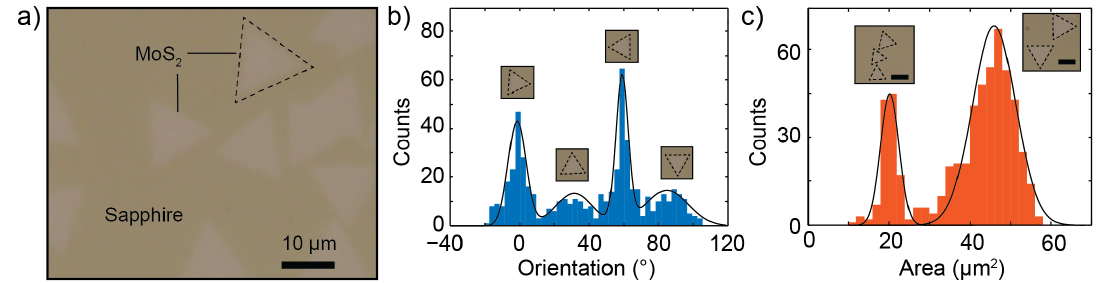
Figure 1. ( a ) Optical image of the grown single layer MoS 2 with triangle shape (the dash ‐ line highlights single crystallites) on sapphire. ( b ) Orientation histogram of 550 MoS 2 crystallites. The black line is a fit to four Gaussian peaks. Inset: orientation of four crystallites corresponding respectively to an angle of 0°, 30°, 60° and 90°. ( c ) Area histogram of 550 MoS 2 flakes. The black line is a fit to two Gaussian peaks. Inset: optical pictures of two different regions of the sample showing respectively small ‐ area crystallites and large ‐ area ones. The scale bar is in both cases 10 μ m.